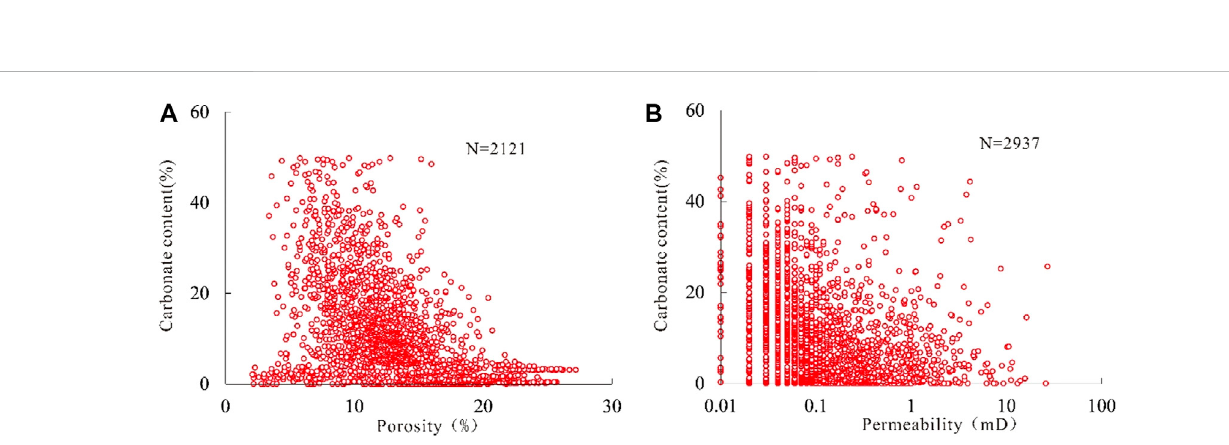
Frontiers in Earth